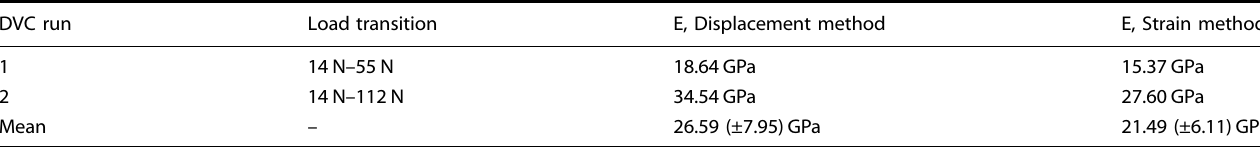
Table 1. Young ’ s modulus calculations based on the DVC-measured data. Both displacement and strain methods were employed. DVC